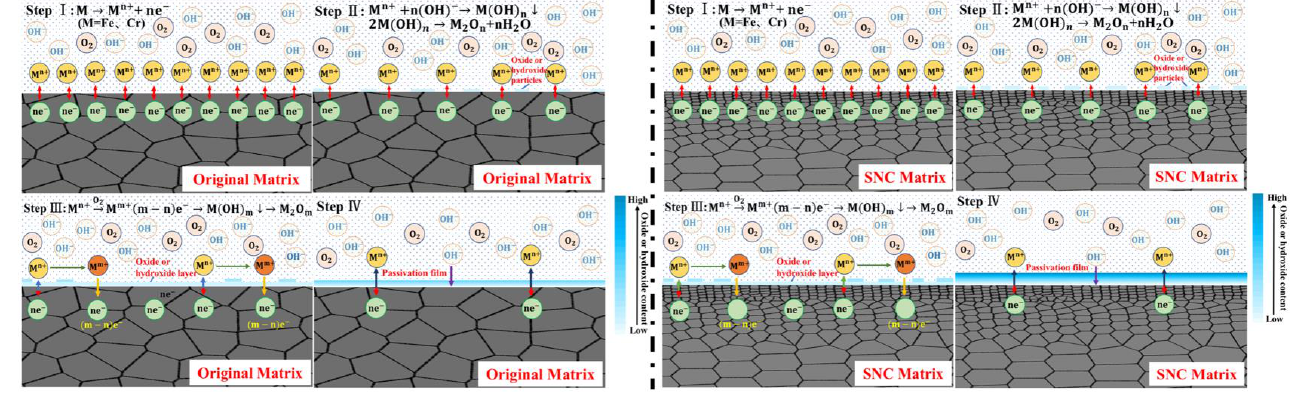
Figure 13. Schematic diagrams of the formation of passive films on SNC rebar and rebar matrix.